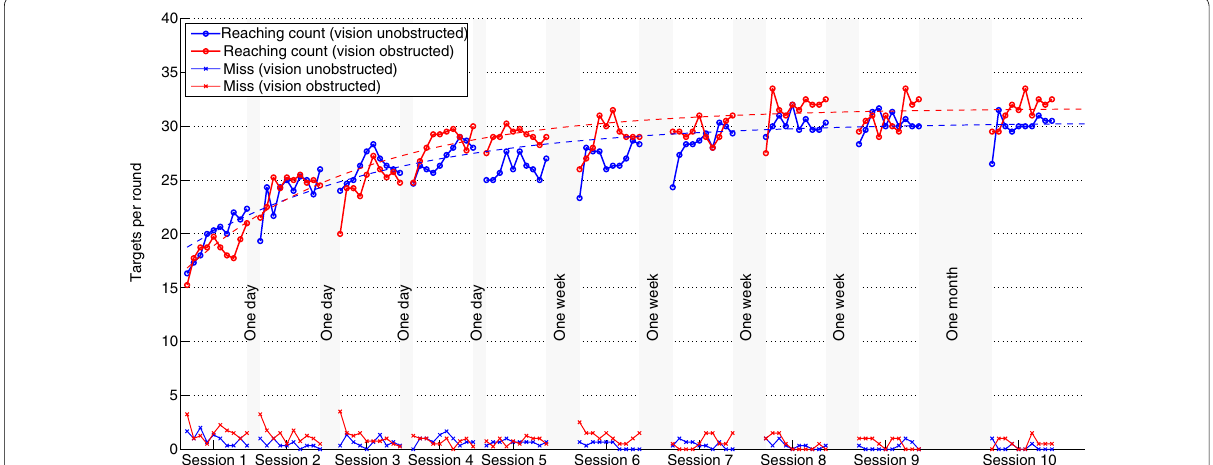
Fig. 8 Number of correct and incorrect fingers touched in each of the 10 rounds per session for both groups. In gray is marked the rest time between sessions